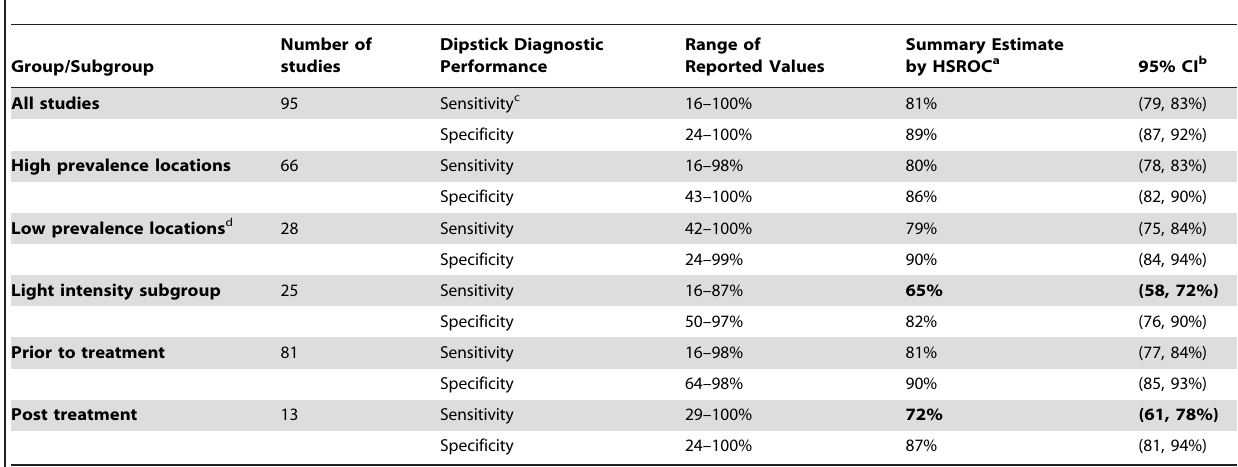
a summary estimate and. b 95% credible interval derived by Bayesian hierarchical summary receiver operating curve (HSROC) analysis [26]. c Sensitivity and specificity for dipstick detection of egg-positive urine. d Prevalence below